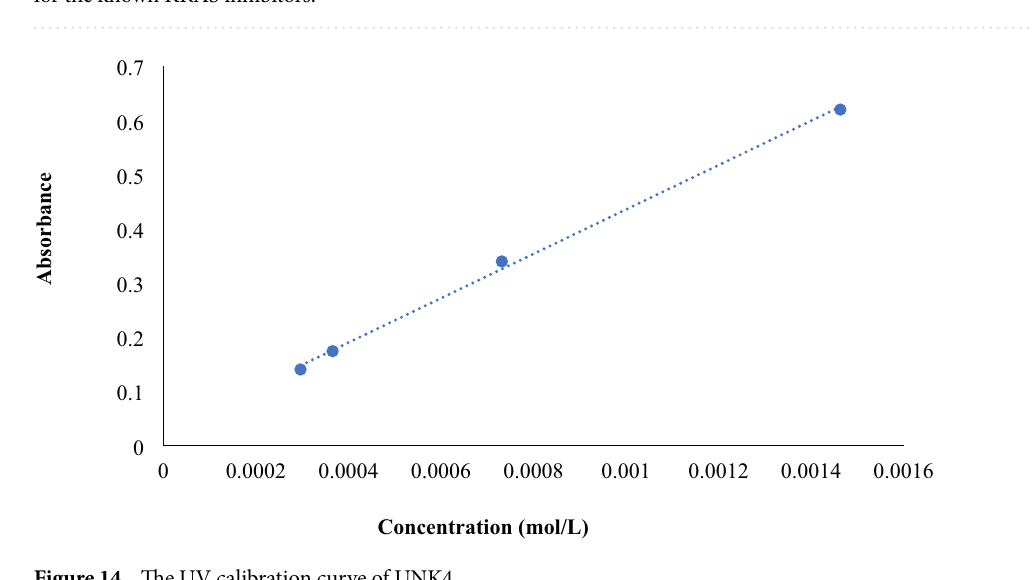
Figure 14. The UV calibration curve of